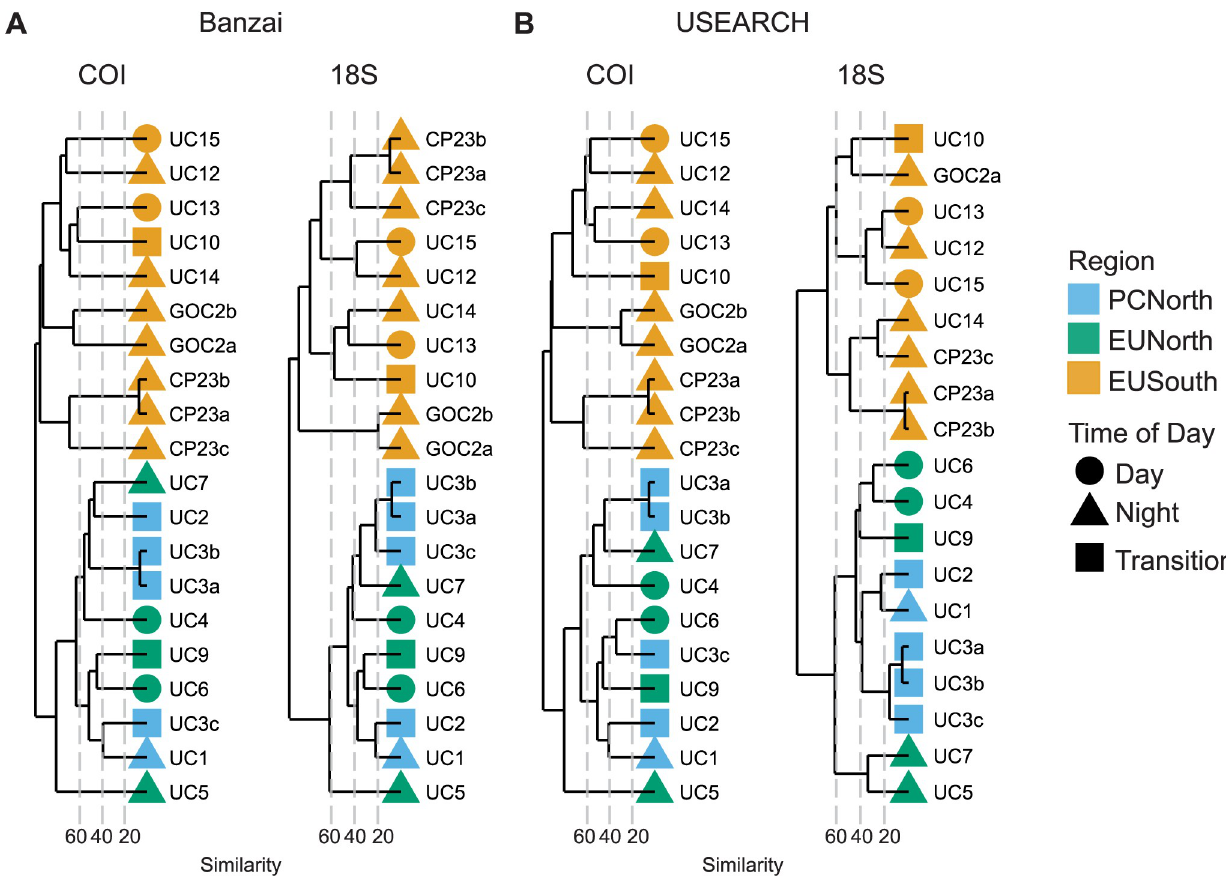
Fig 3. Hierarchical clustering of samples. Hierarchical clustering of samples by Bray-Curtis distance across both markers and pipelines.